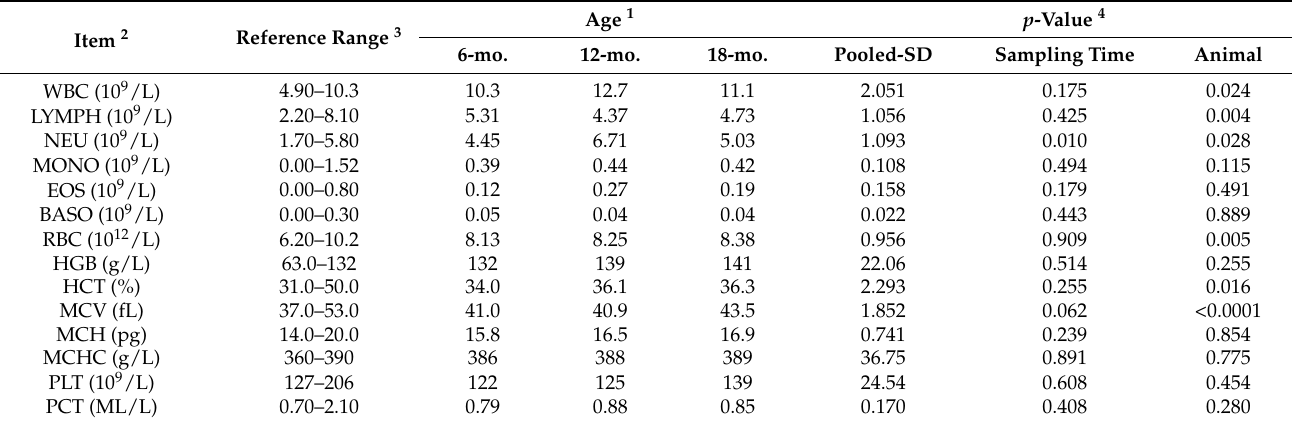
Table 2. Hemogram (CBC) of foals across the different growth